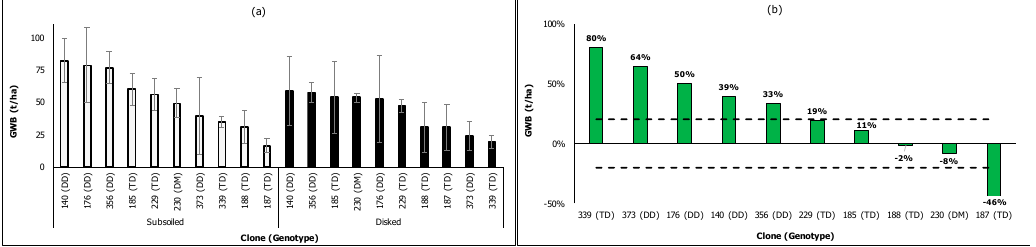
Figure 7. ( a ) Four-year-old green wood biomass (t/ha) of non-irrigated poplar stands in the coastal region (WD) using two soil preparation methods; ( b ) increases (%) in clonal wood biomass at subsoiled plots (WDSS) relative to those at disked plots (WDD).